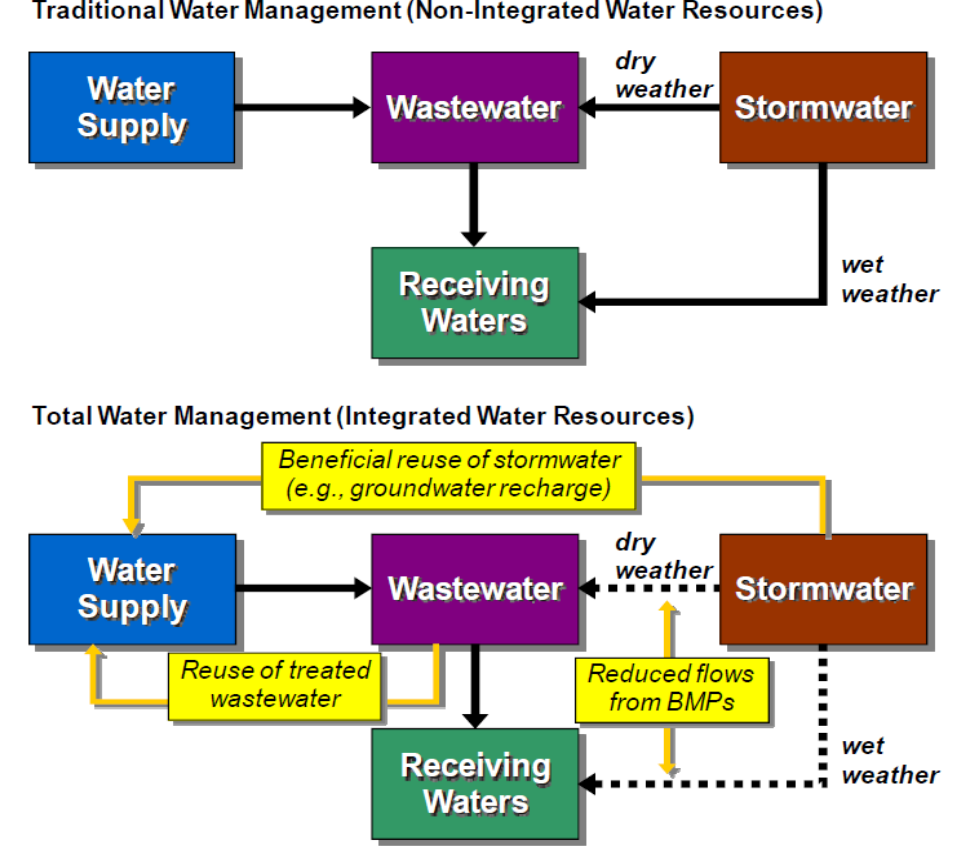
Figure 1. Traditional vs. total water management for municipal separate storm sewer systems (reused from O’Connor et al. [17], licensed by CCC Marketplace TM ).